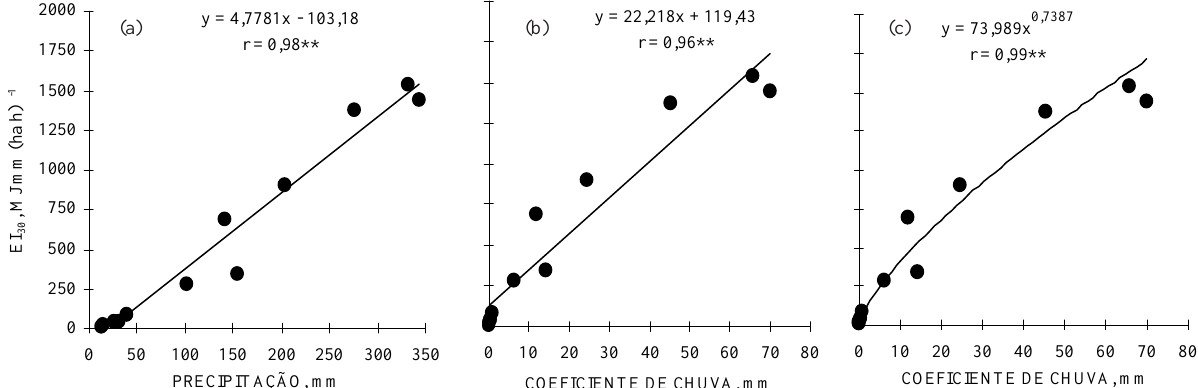
Figura 1. Regressões entre o índice de erosividade EI em Fortaleza (CE) no período de 1962 a 1981.